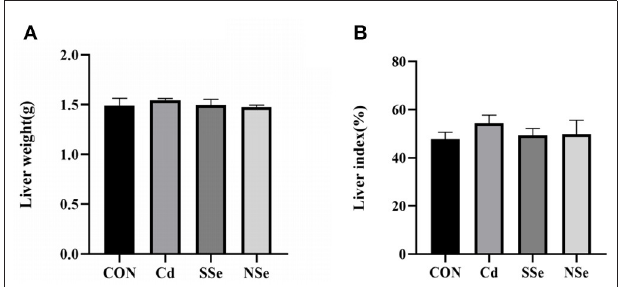
FIGURE 1 | Hepatic weight and liver index. (A) Liver weight; (B) Liver index. Data were presented as the mean ± SD. Different letters represented a statistically significant difference ( P < 0.05) within the column, and the same letters represent no significant difference ( P > 0.05). CON, control group; Cd, cadmuim group; SSe, sodium-selenite group; NSe, nano-selenium group.